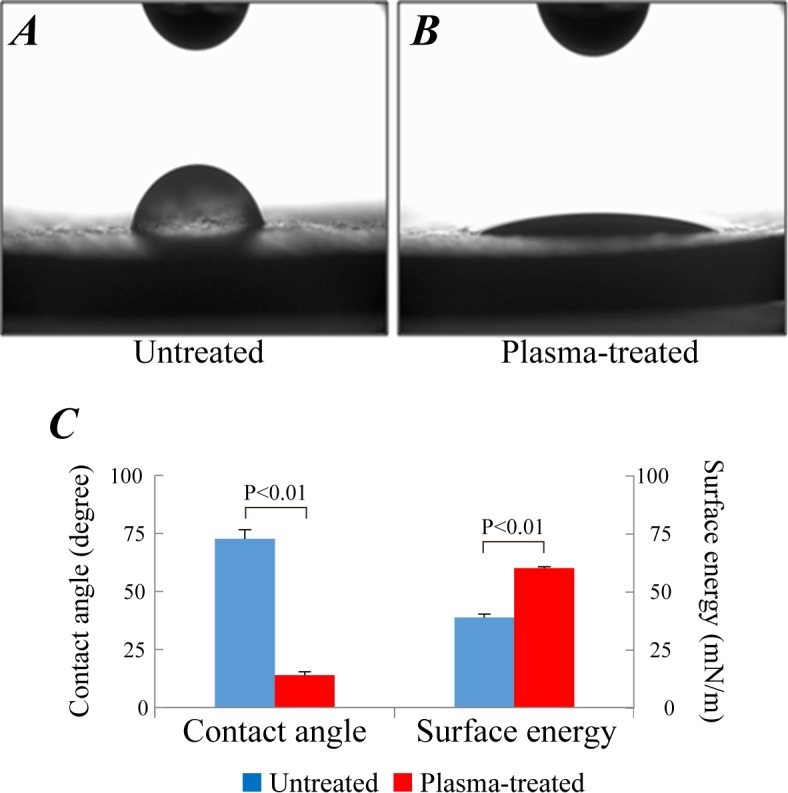
Change of surface wettability after 5 min of plasma treatment.Photographs of water drops on the surfaces of non-porous HA pellets. (A) untreated and (B) plasma-treated pellets. (C) Quantitative analysis of contact angles and surface energy. Data were expressed as mean ± standard deviation (SD).